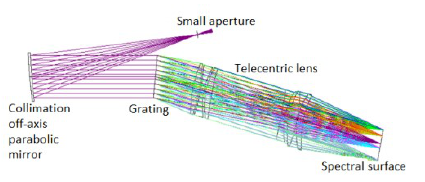
Figure 2 Optical design of grating spectrometer The aperture is used to limit the receiving field of view in the receiving telescope, and